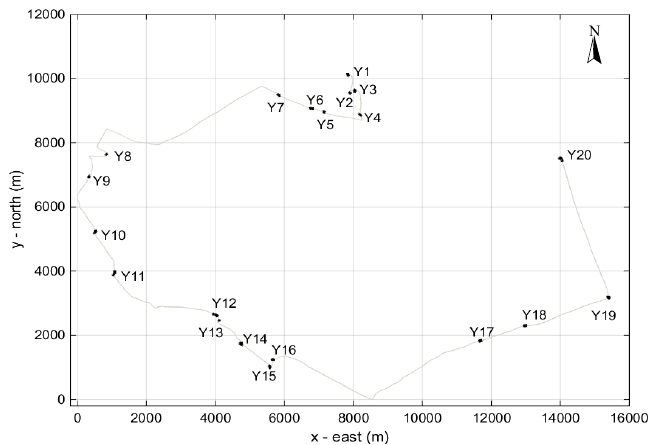
Figure 19. Vessel track on 8 June 2015 aiming at the localization of sperm whale Y. The area corresponds to rectangle “Y” in Figure 3. The stations (Y1–Y20) are marked by black dots.